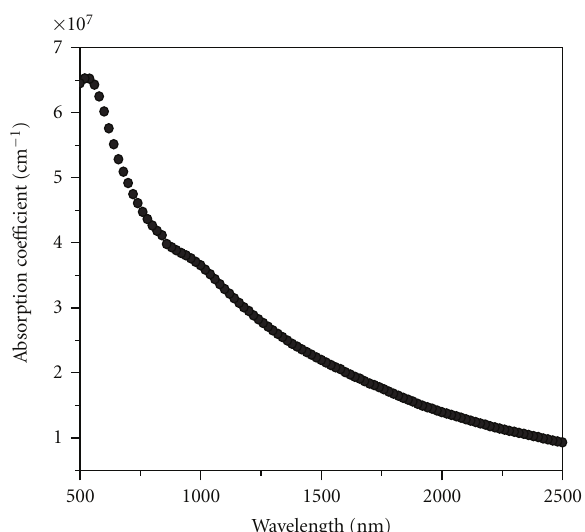
Figure 6: Variation of absorption coe ffi cient on wavelength.